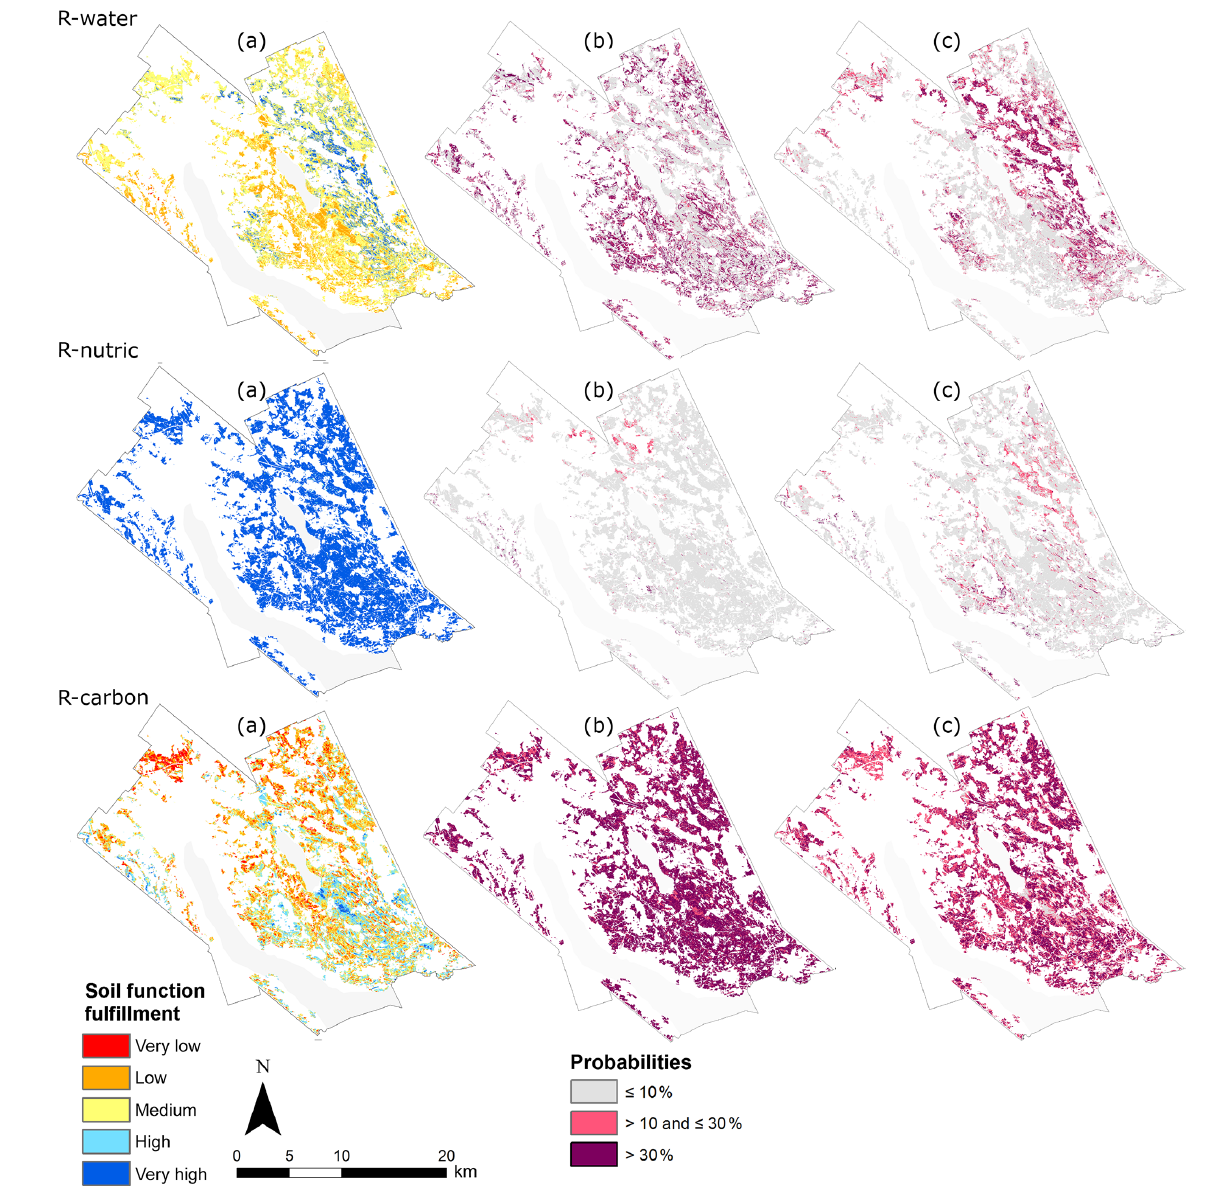
Figure 2. Selected soil function maps for the agricultural land of the case study area and indication of their uncertainties in the ordinal scale: (a) mean SFF scores and (b) probability that the mean SFF score of a raster cell deviates in the ordinal scale for ± 1 or (c) ± 2 or more SFF categories/classes (raster cells 20 × 20m 2 , N = 1000